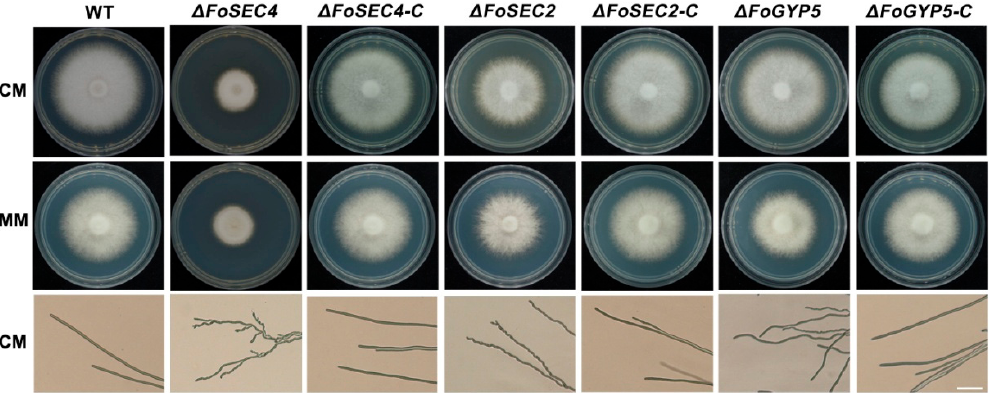
Figure 3. Vegetative growth of the wild-type (WT), Δ FoSEC4 , Δ FoSEC2 , Δ FoGYP5 , Δ FoSEC4-C , Δ FoSEC2-C and Δ FoGYP5-C strains. All strains were cultured on CM and MM plates at 28 °C for 3 days. The hyphae on the CM plate were photographed by microscopy. Bar=50 µm